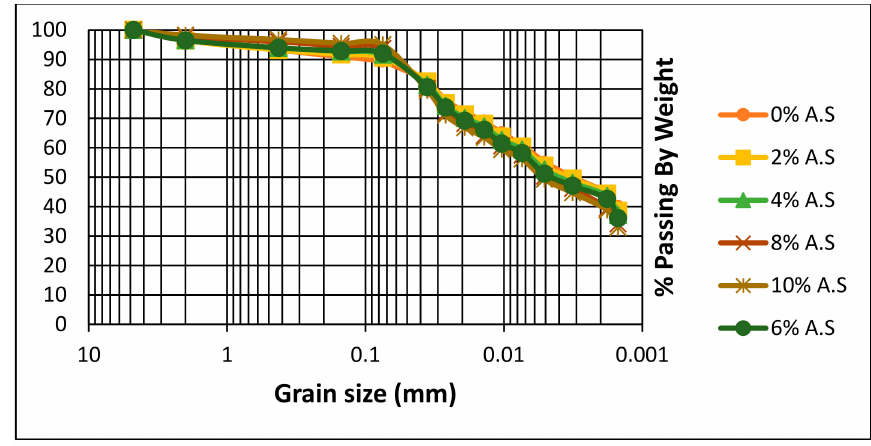
Figure 2. Particle size analysis of soil sample before and after the addition of alum sludge.